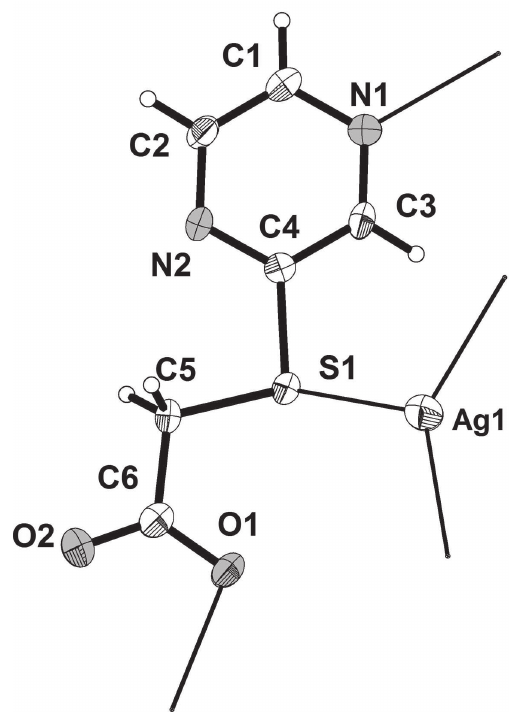
Table 1: Data collection and handling.